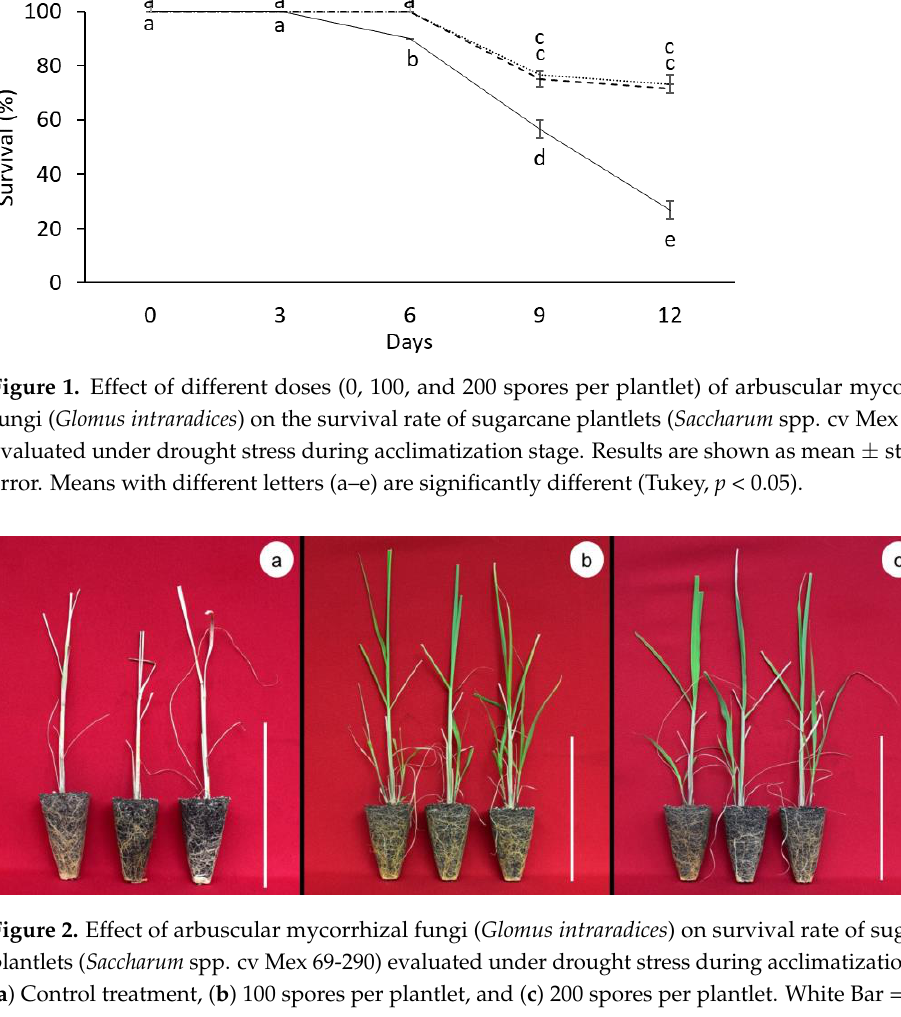
Figure 3. Colonization of sugarcane plantlets ( Saccharum spp. cv Mex 69-290) with Glomus intra- radices 60 d after spore inoculation. Fungal structures, such as spores (sp) and intracellular hyphae